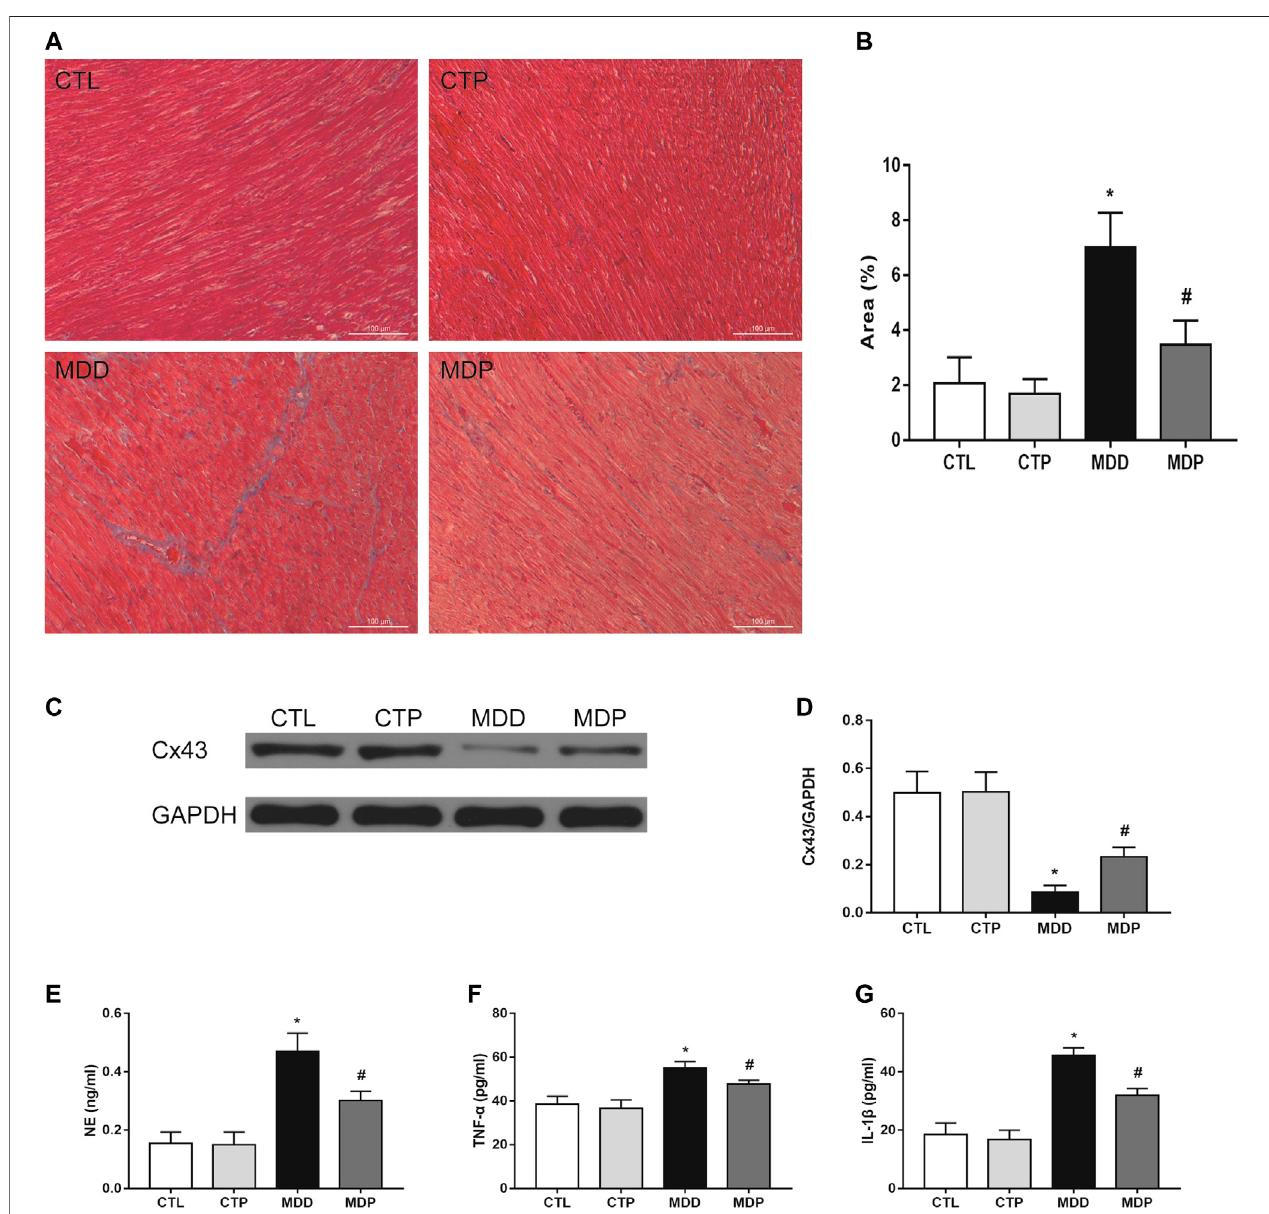
FIGURE 8 | Ventricular myocardial fi brosis, Cx43 expression, and ELISA. (A,B) Representative images of Masson staining in LV and quanti fi cation of the fi brotic area (original magni fi cation: × 200), respectively. n (cid:1) 7 per group. (C,D) Immunoblotting and expression ratio of Cx43, respectively. n (cid:1) 7 per group. (E – G) Serum NE, TNF- α , and IL-1 β concentrations, respectively. n (cid:1) 7 per group. * p < 0.01 vs. CTL; # p < 0.01 vs. MDD. LV, left ventricle.